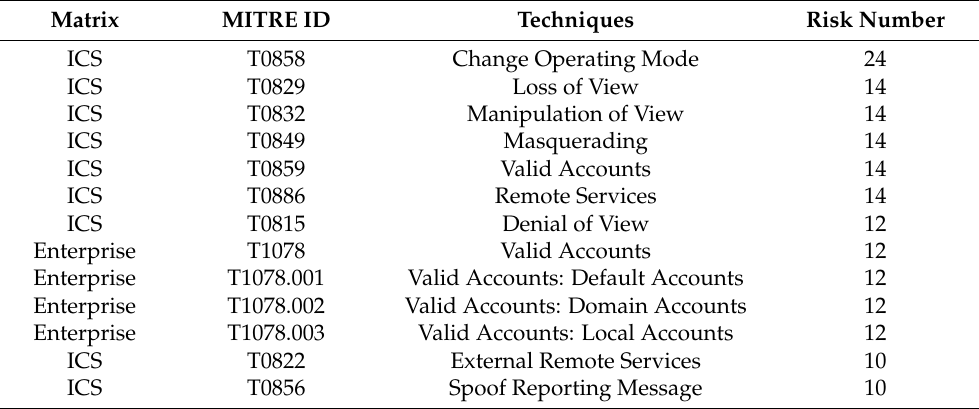
Table 13. Techniques compromising over 10